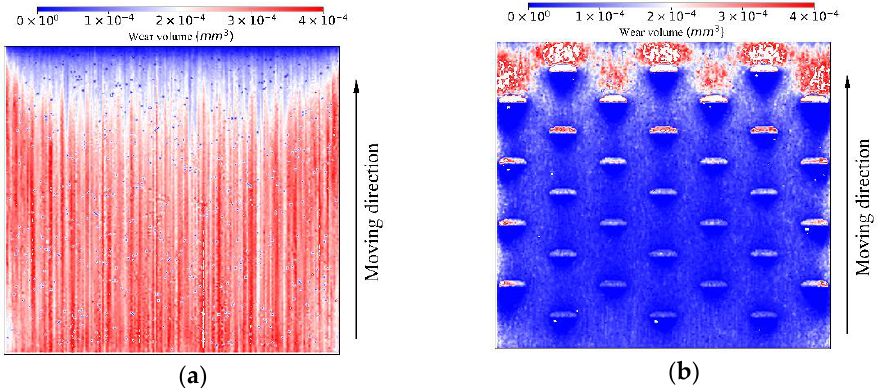
Figure 17. Wear distribution of samples for a scaling factor of 1. ( a ) Flat surface; ( b ) Convex pattern surface.